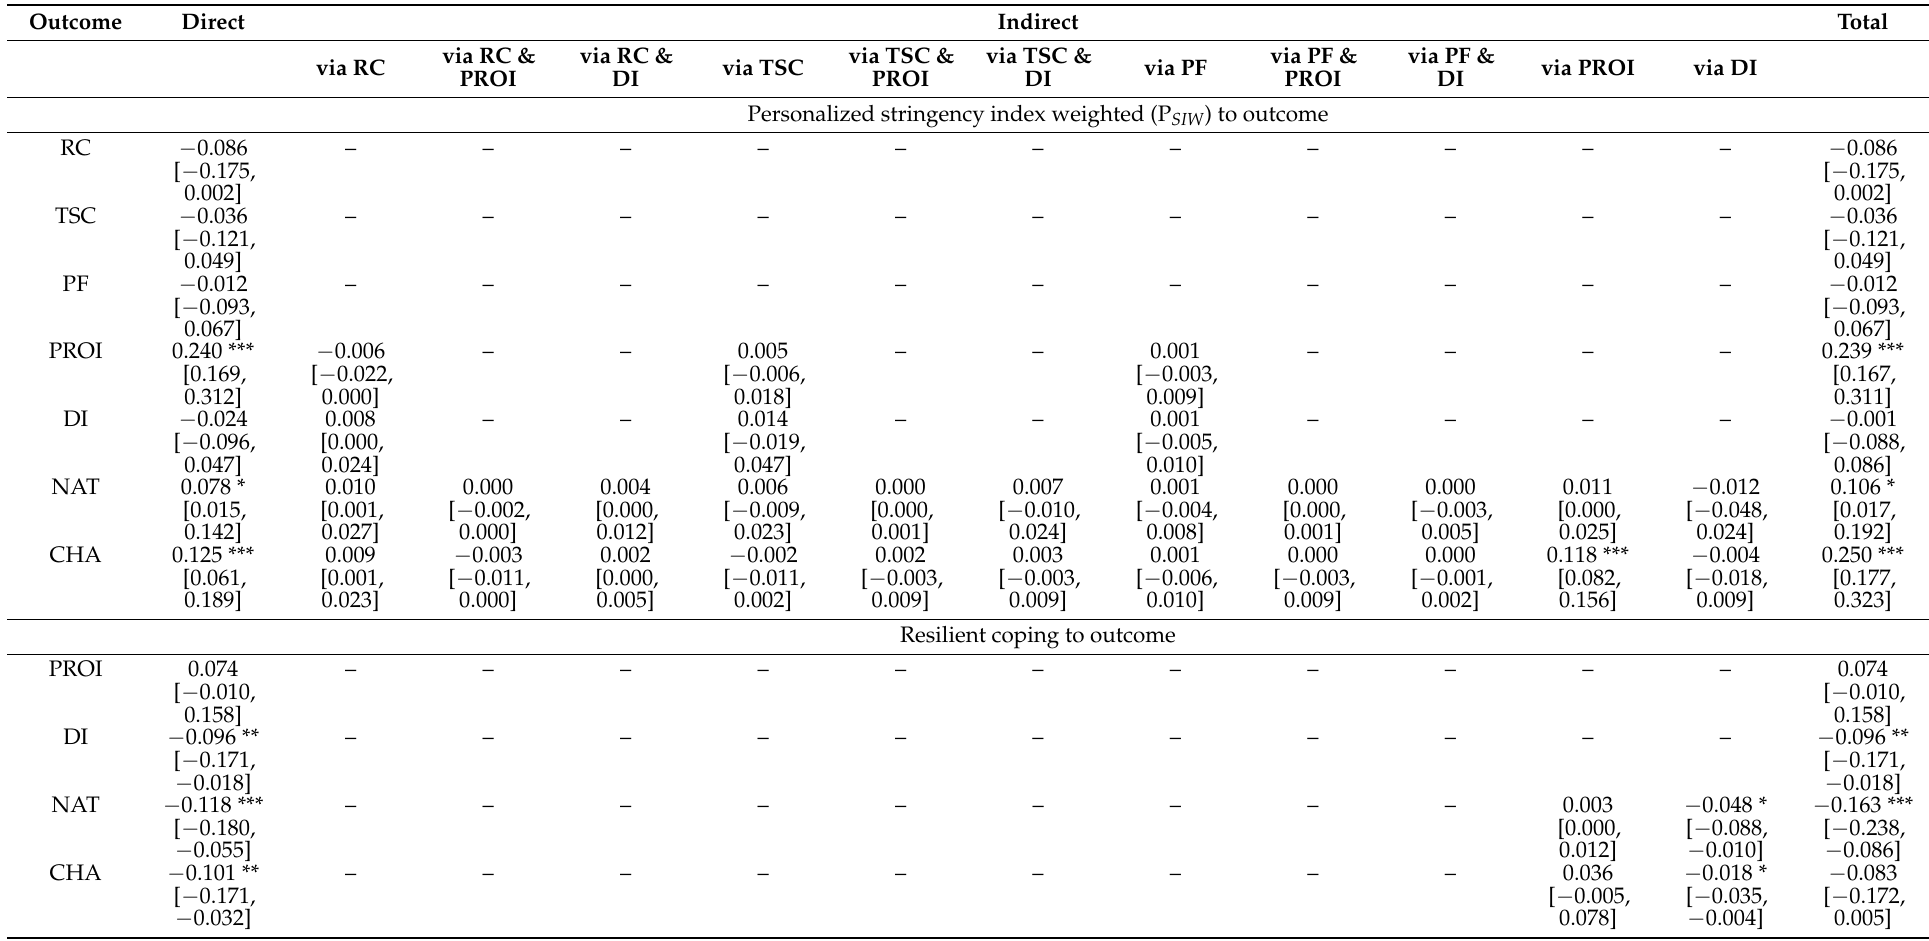
Table 3. Direct, indirect, and total effects of the personalized stringency index (P SIW ) and psychological protective factors on COVID-19-related